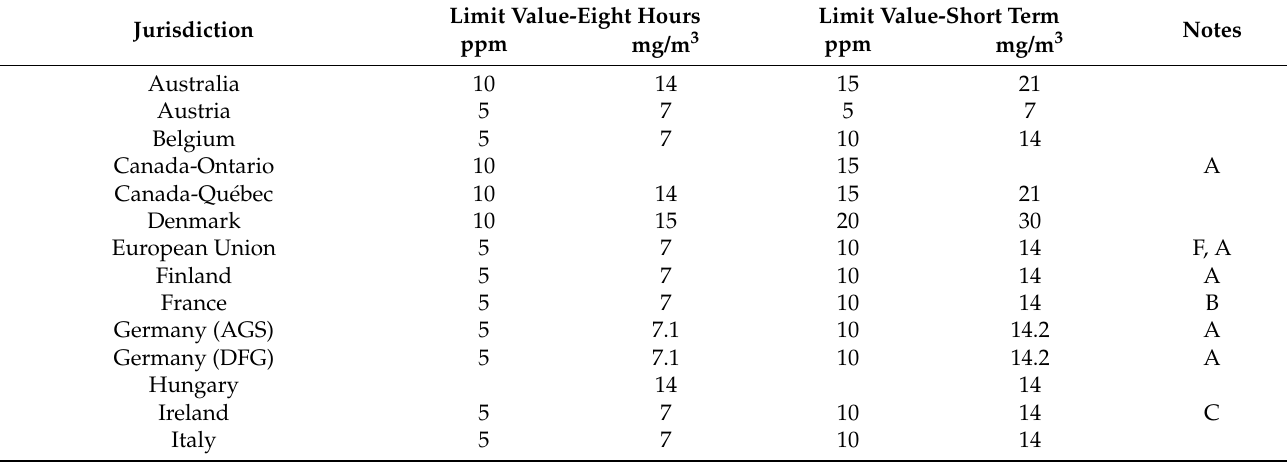
Table 1. Occupational exposure levels for hydrogen sulphide currently in 31